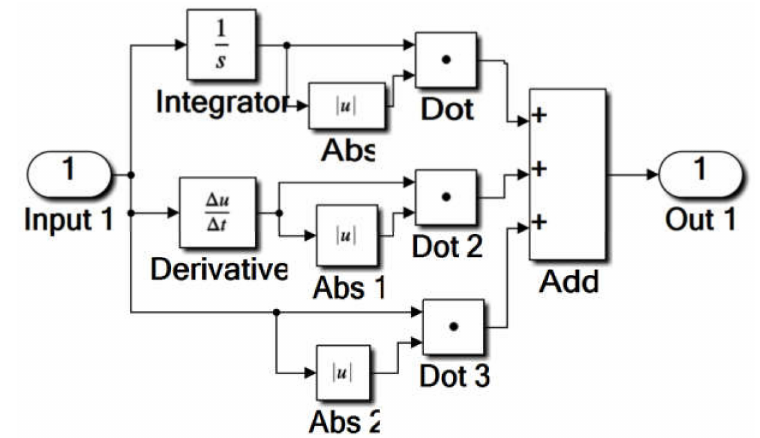
Figure 7. Design of the simple PID